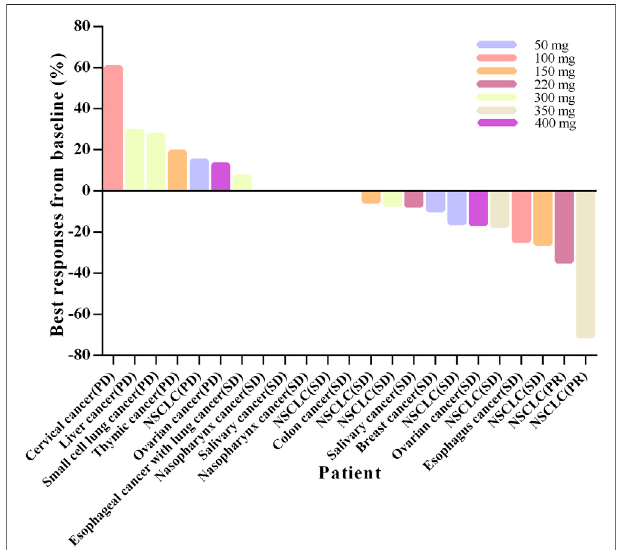
FIGURE 4 | Percentage change in tumor size of the target lesions by RECIST (version 1.1) in patients from baseline to best responses. Abbreviations: NSCLC, non-small cell lung